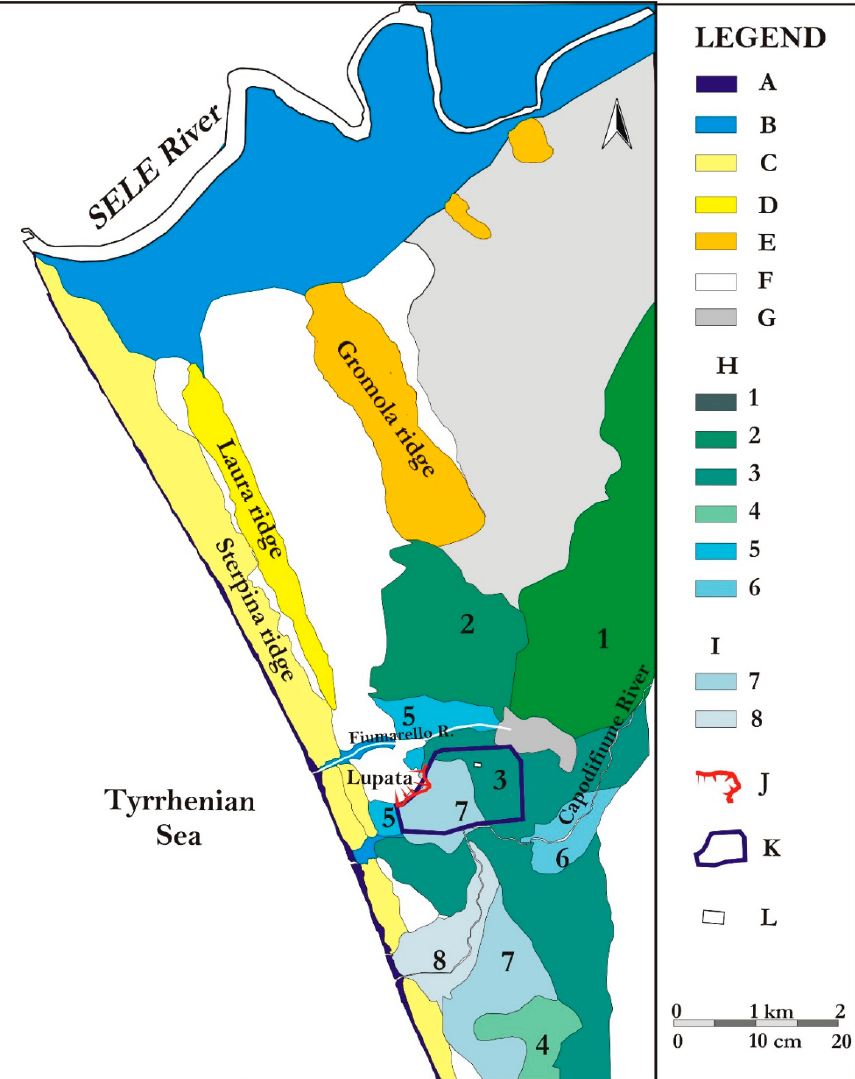
Figure 3. Schematic geological map of the southern sector of the Sele river alluvial-coastal plain (from Amato et al., 2013, modified). A: modern beach; B: fluvial deposits (Holocene); C: Sandy dunal ridge (Late Holocene); D: Sandy dunal ridge (Early Holocene); E: Sandy dunal ridge (Upper Pleistocene, MIS5); F: Clay and silt of retro-dunal depression (Upper Pleistocene–Holocene); G: Marshy deposits (Holocene); H: Lower Paestum Travertine (Upper Pleistocene–Early Holocene), (1) Cafasso Unit (Middle-Late Pleistocene, before 50 ka BP), (2) Gaudo Unit (late Middle Pleistocene–Late Pleistocene), (3) Paestum Unit (Late Pleistocene–Early Holocene), (4) Mancone Unit (Middle Holocene), (5) Arcione Unit (Middle Holocene: before 2.5 ka BP), (6) Spinazzo Unit (Holocene: 2.5–1.7 ka BP); I: Upper Paestum Travertine (Late Holocene), (7) Linora and Fossa Lupata Unit (Holocene: after 1.7 ka BP), (8) Licinella Unit (Holocene: Middle Age-Present); J: Porta Marina palaeocli ff (Early Holocene); K: Paestum city walls; L: Athena